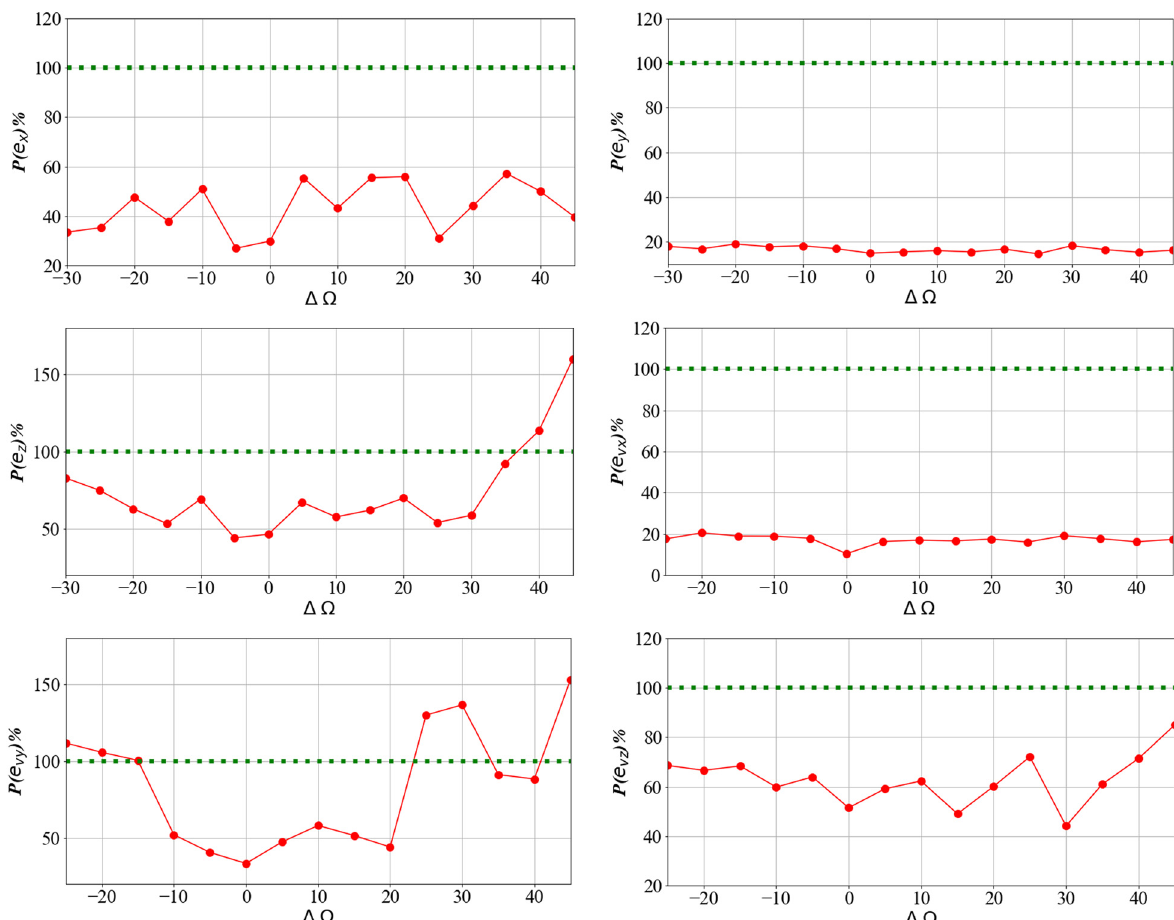
Figure 7: Generalization performance of PCA – XGBoost model training on original satellite and testing on satellites with di ff erent